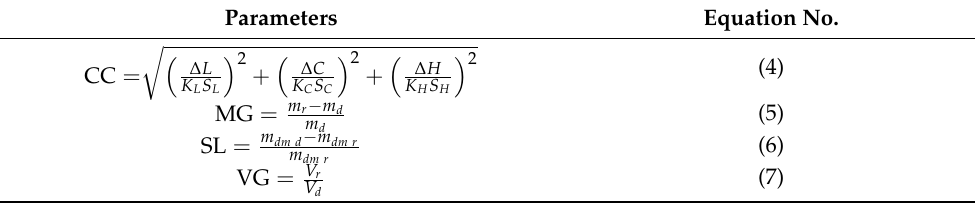
Table 1. Equations for quality parameters calculating of rehydrated apple.